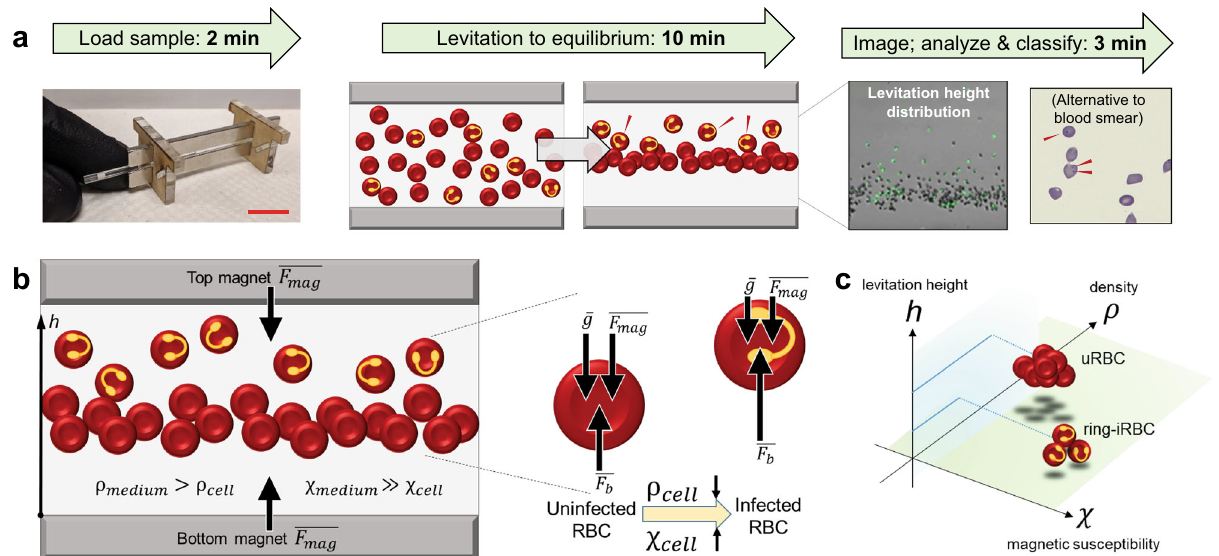
Fig. 1 Mechanism of magnetic levitation for erythrocytes (RBCs). h refers to levitation height ( µ m), Χ refers to magnetic susceptibility (unitless), and ρ refers to density (g/mL). RBC refers to red blood cells, or erythrocytes, uRBC to uninfected RBCs, ring-iRB to ring-stage synchronized infected RBCs, and troph-iRBC to trophozoite-stage (i.e., more mature) infected RBCs. a Work fl ow: First, a volume of blood (smaller than a fi ngerprick) is mixed with a paramagnetic solution within a glass capillary and loaded into the magnetic device. Scale bar = 1 cm. Second, cells begin to levitate at different heights, arriving at equilibrium within 12 – 16 min and resulting in height-based separation of different cell types. Third, cell levitation patterns in the device are imaged upon equilibrium using a microscope for analysis. Captured images are analyzed to produce levitation height distributions. Red arrows mark ring- stage infected RBCs in the schematic and images. b Schematic of device containing a Plasmodium falciparum -infected blood sample. RBCs (slightly less dense than the medium) levitate at equilibrium in the upper half of the channel (due to buoyancy and gravity), and, being relatively diamagnetic compared to the paramagnetic medium, away from the region of high magnetic gradient near the top magnet (due to the repulsive magnetic force). Infected blood samples have some RBCs containing ring-forms of the parasite, which are hypothesized to decrease the density and increase the magnetic susceptibility of the host RBC, thereby increasing buoyancy and decreasing the effects of gravity and magnetic repulsion. Thus, parasite-containing RBCs are hypothesized to levitate higher ( z -axis) than uninfected RBCs. c As this 3-dimensional plot schematic shows, levitation height h can be used as a single metric to represent the multiparametric biophysical pro fi le of single cells — in this case, density and magnetic susceptibility as they change in P. falciparum - infected